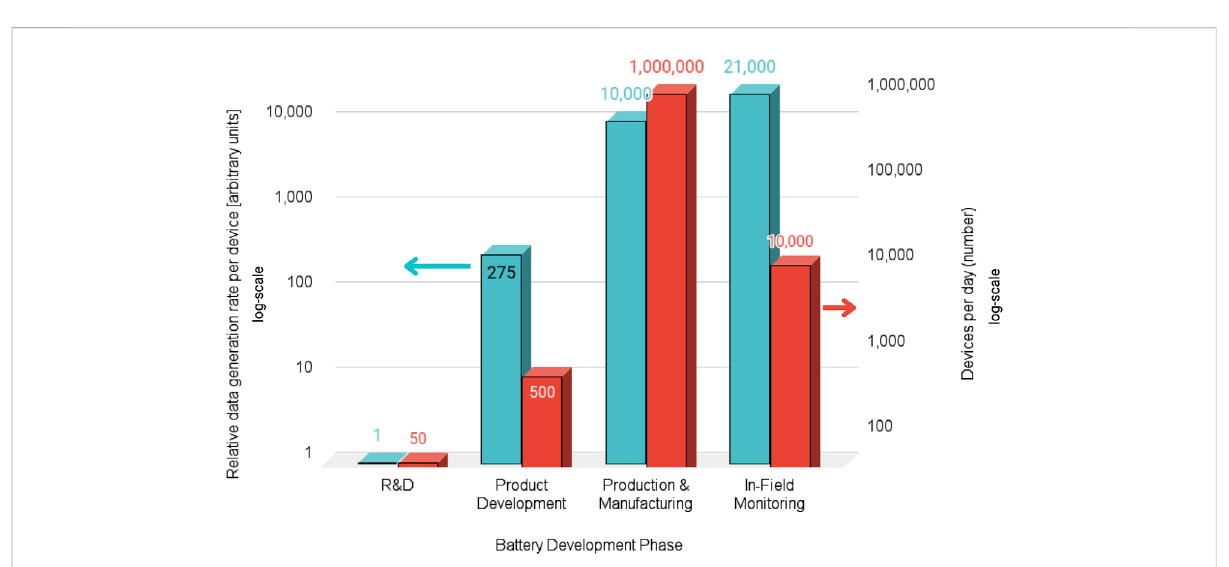
FIGURE 3 Relativedata volumegenerationratesper testeddevice (leftaxis inteal)and numberofdevices tested perdayatasingle organization(right axis in red) for data collected at the four stages of battery lifecycle. Both the left and right axis are log